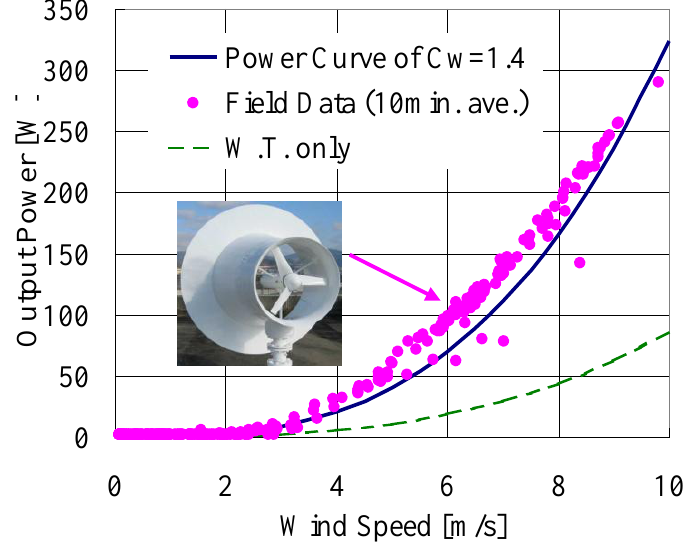
is the power coefficient. w